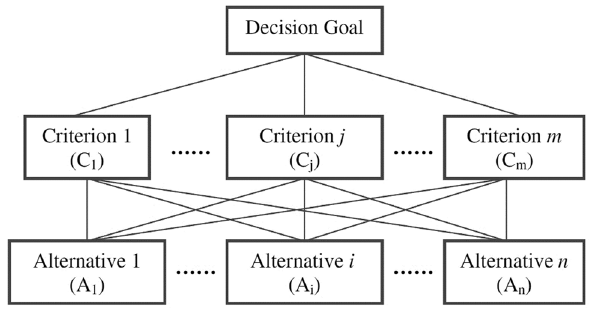
Fig. 2 A three-level hierarchy for a MCDM problem (Wang et al. 2008)